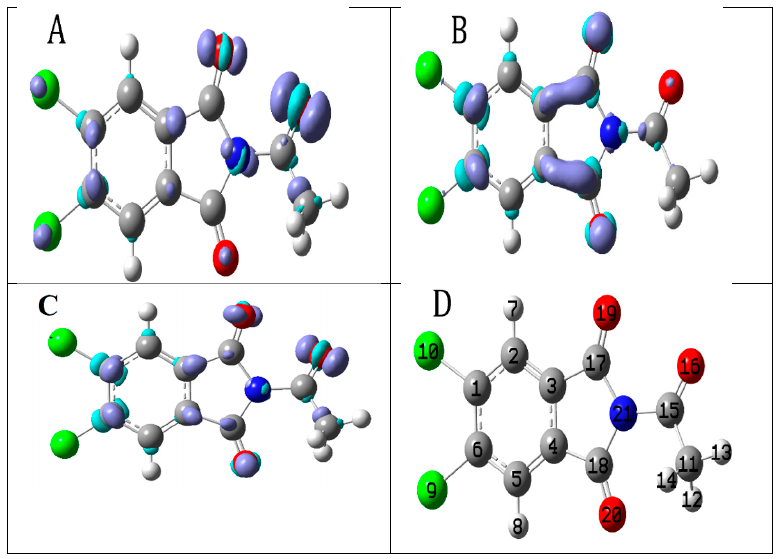
Figure 5. Fukui function describing the sites(lobes) on compound 2 more susceptible to ( A ) electrophilic [ f − (r)] attacks, ( B ) nucleophilic [ f + (r)] attacks, and ( C ) radical [ f 0 (r)] attacks ( D ) labeled structure.